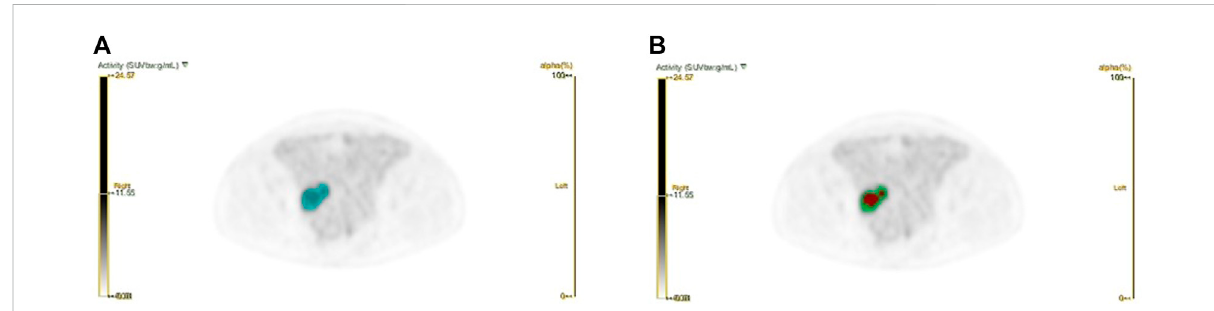
FIGURE 2 Schematic diagram of Habitat method. (a) The blue area represents the whole tumor area; (b) Based on the whole tumor area, we have implemented the subarea partition by habitat algorithm.